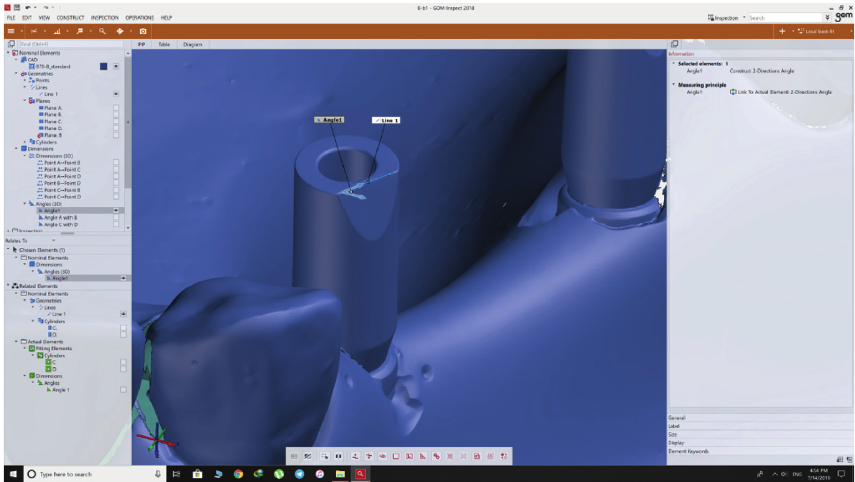
Figure 5: Determination of the angle of rotation around the longitudinal axis of the scan body. Table 1: The mean and standard deviation of rotational dis- Table 3: Comparison of the accuracy of the two scanners in the placement (in degrees) of implants in the three models scanned by three models bilaterally using one-way the two scanners ( n � 12).